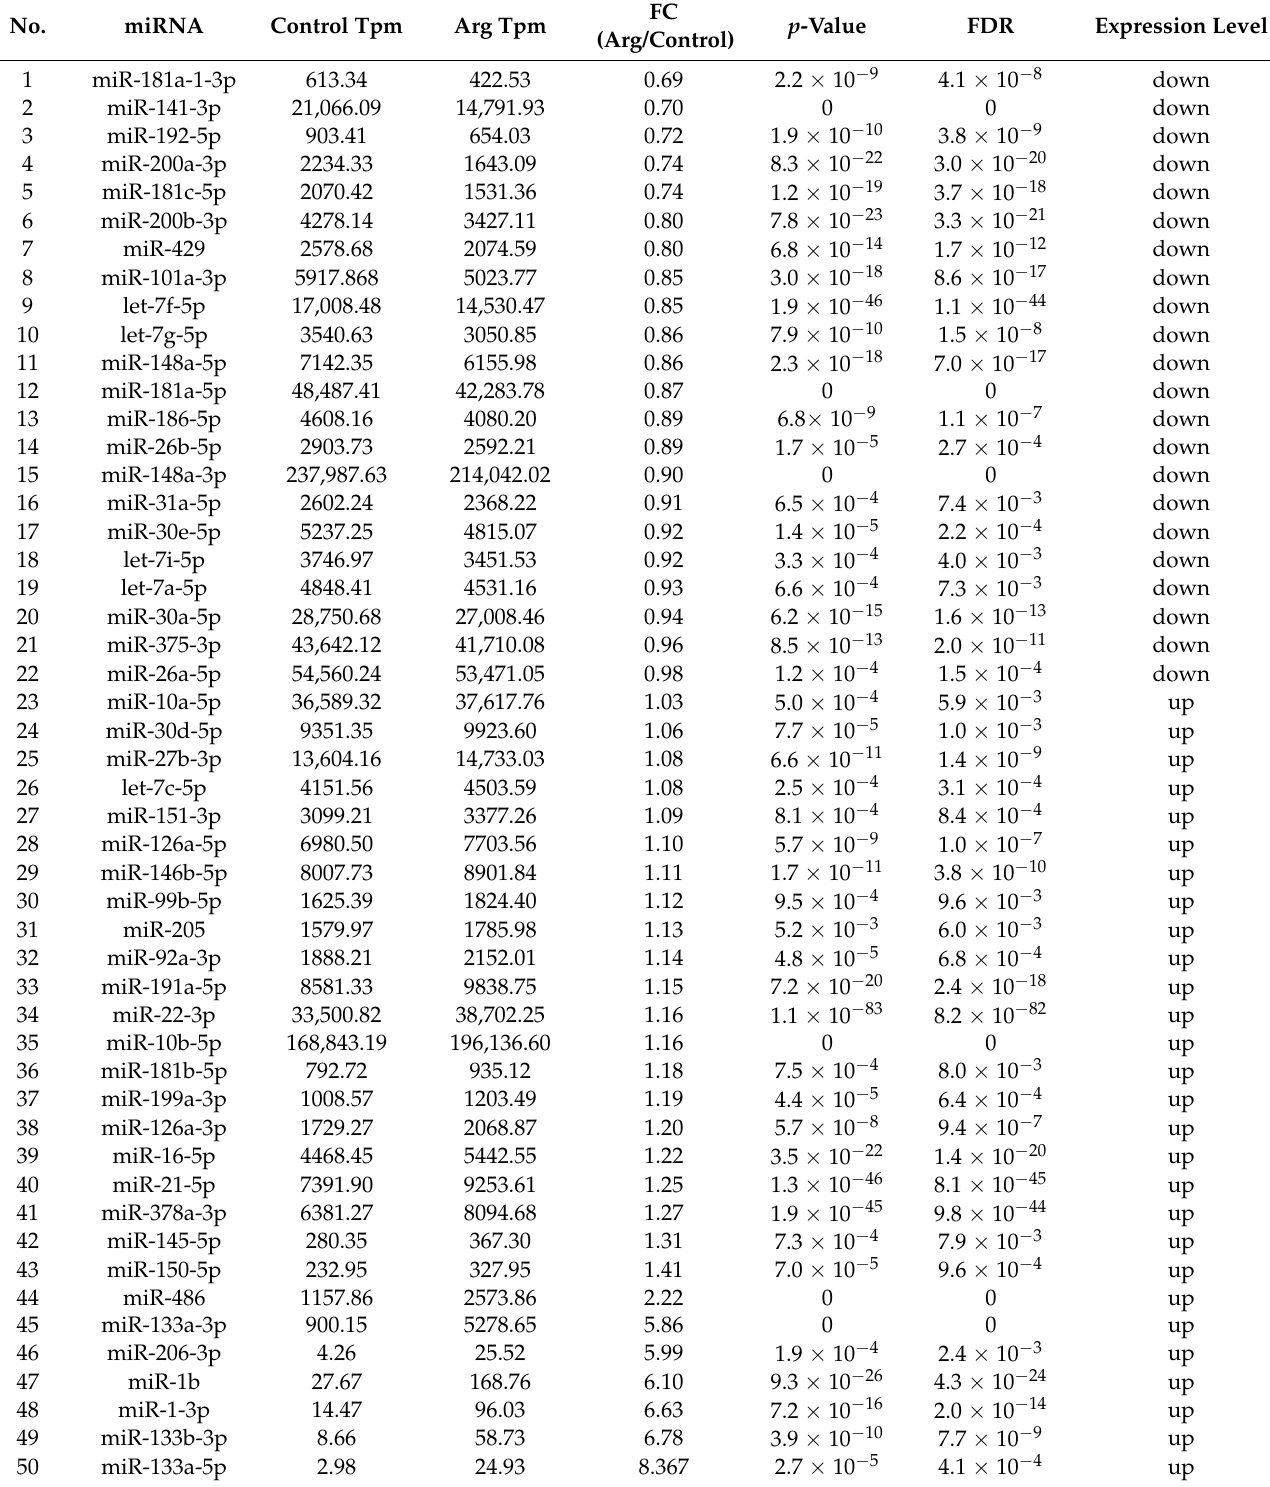
Table 2. Differentially expressed miRNAs with different treatment by RNA-Seq